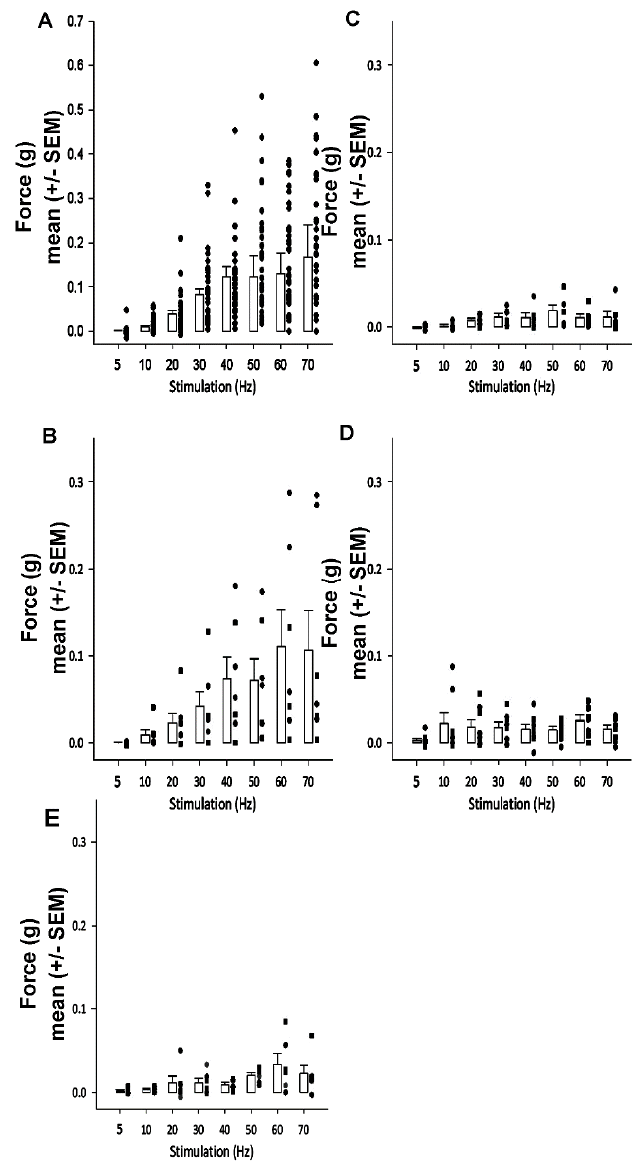
Figure 7. Change in force over stimulation paradigm with before and after regions of fibers being ablated: The bar graphs are of the mean and standard error of the mean ( +/ − SEM) at each of the 8 stimulation frequencies. Each dot represents a preparation. ( A ) The force generated by the intact opener muscle for all 34 preparations prior to ablating the tissue. ( B ) The force generated by the central and proximal fibers when the distal fibers were ablated. ( C ) The force generated by the distal and proximal fibers when the central fibers were ablated. ( D ) The force that can be generated by the proximal fibers alone when both central and distal fibers were ablated at the same time. ( E ) The force that can be generated by the proximal fibers when the central and proximal fibers were ablated.